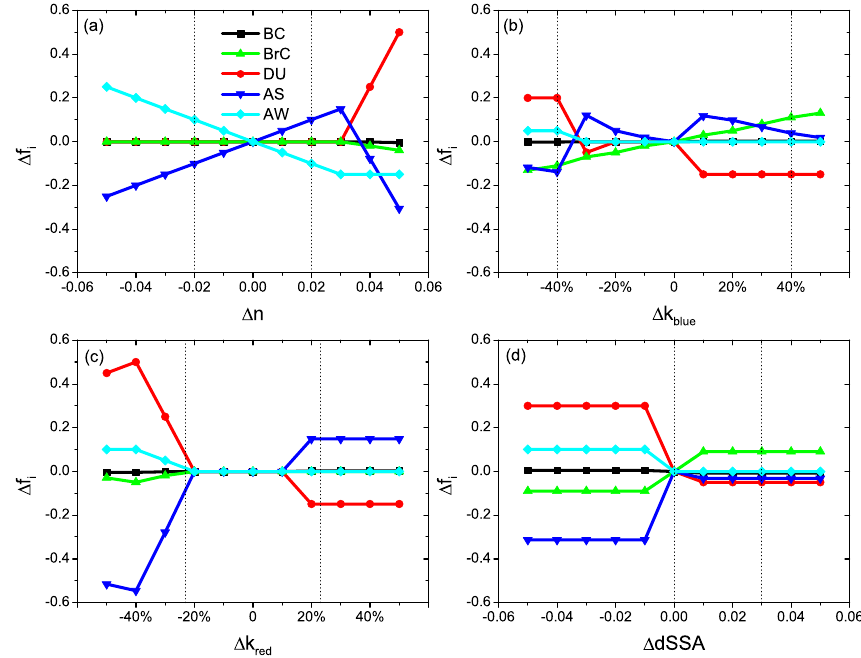
Fig. 5. Uncertainty in the retrieval of aerosol component fractions. Errors in n , k blue , k red and dSSA are assessed with their expected uncertainty ranges marked by dot lines in each